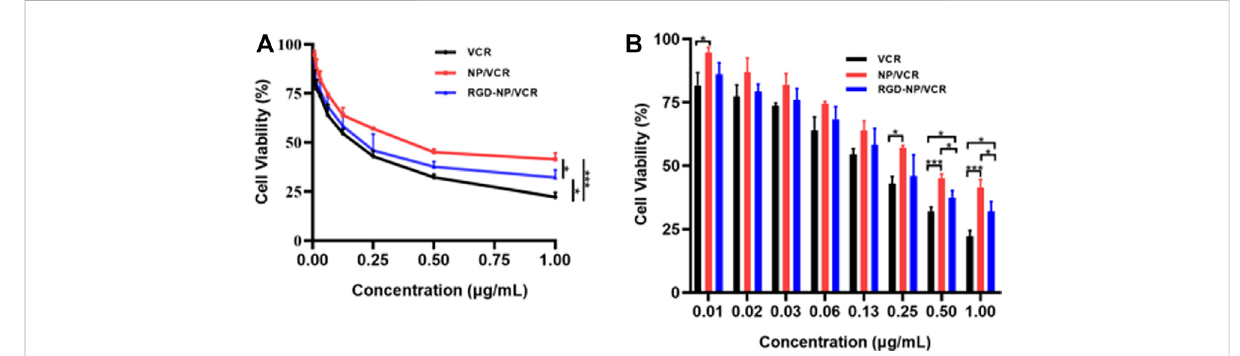
FIGURE 2 (A,B) The inhibition ef fi cacies of VCR, NP/VCR, and RGD-NP/VCR on LLC cells in vitro . The data in each group is showed by mean ± SD ( n = 3, NS: No signi fi cance, * p < 0.05, *** p < 0.001).